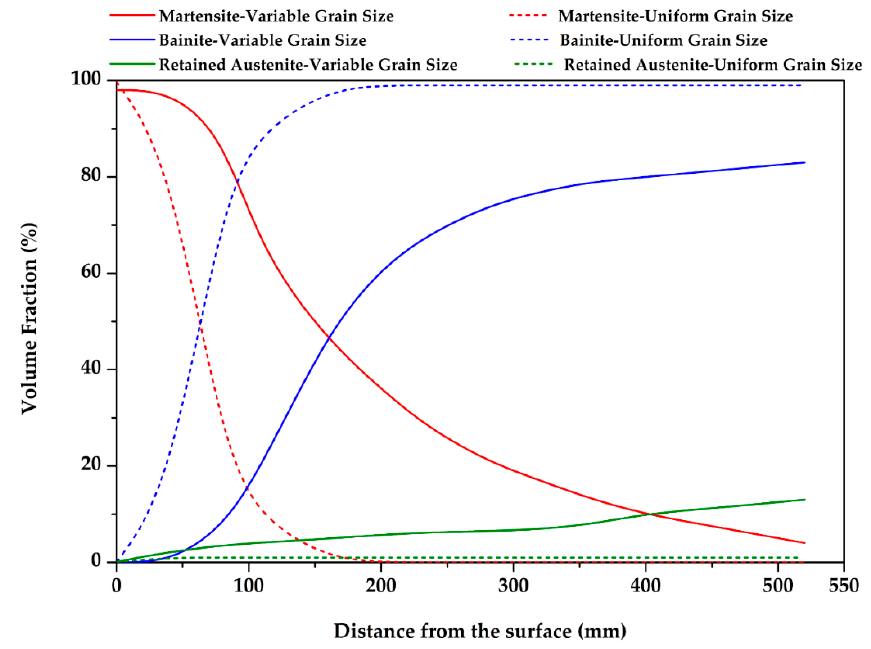
Figure 8. Effect of carbon content on the predicted phase distribution along the depth of the block after water-quenching process. Dashed line condition (A); Solid line condition (C).